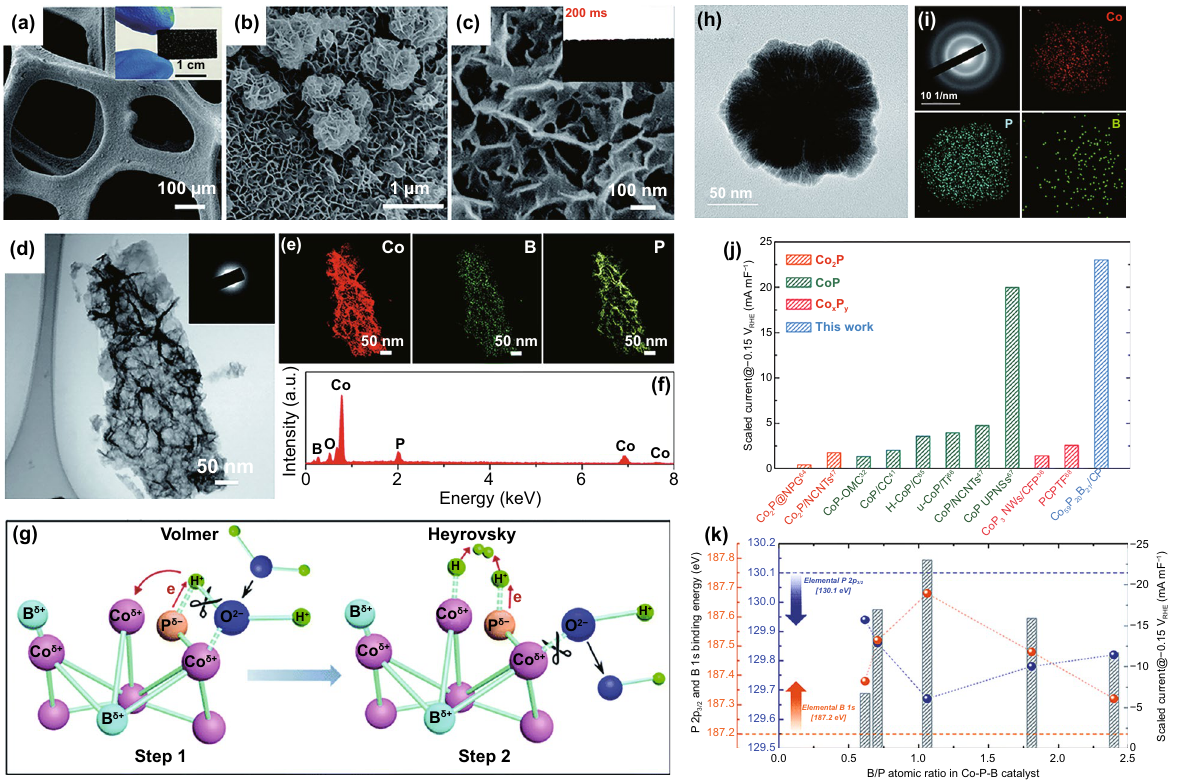
Fig. 15 a Low-magnification and b , c high-magnification SEM images of synthesized Co–B–P/NF, d TEM image and SAED pattern (inset), e elemental mapping and f the corresponding EDS spectrum of Co–B–P sheets scraped off from the Ni foam substrate, g Schematic HER elec- trocatalysis on Co–B–P with a synergistic effect of Co, B and P. Reprinted with permission from Ref. [74]. Copyright Year 2018. Royal Society of Chemistry. h TEM image, i SAED patterns and elemental mapping images of Co 59 P 20 B 21 /CP catalyst, j Comparison of HER performance in 0.5 M H 2 SO 4 with other CoP x electrocatalysts reported in literature, k Scaled current of Co–P–B catalyst corresponding to binding energy of P 2 p 3/2 (navy) and B 1 s (orange) with atomic ratio of catalyst. Reprinted with permission from Ref. [207]. Copyright Year 2018. Royal Society of